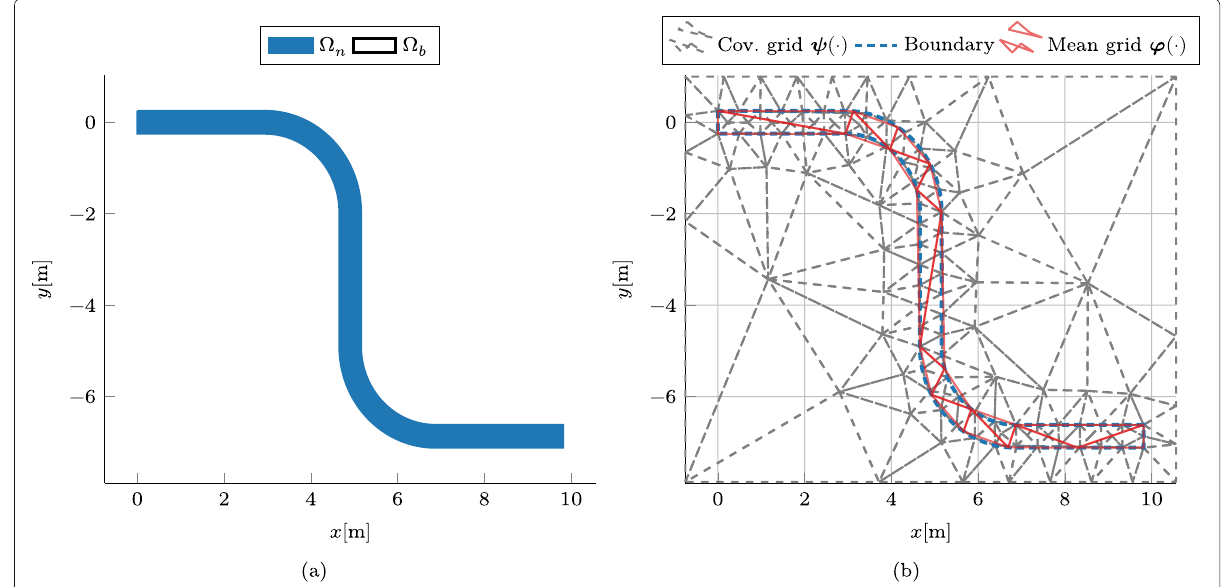
Fig. 1 a shows the simulation setup and the differentiation between the two domains: the normal domain (cid:4) n (blue), which is equivalent to the fluid-carrying part, and the barrier domain (cid:4) b (white), where no fluid is present. b visualizes both the mean and covariance parts of the FEM mesh. In total, N α = 127 grid vertices and ψ basis functions are used for the covariance field in this example, and N β = 19 grid vertices and ϕ basis functions are used for the mean